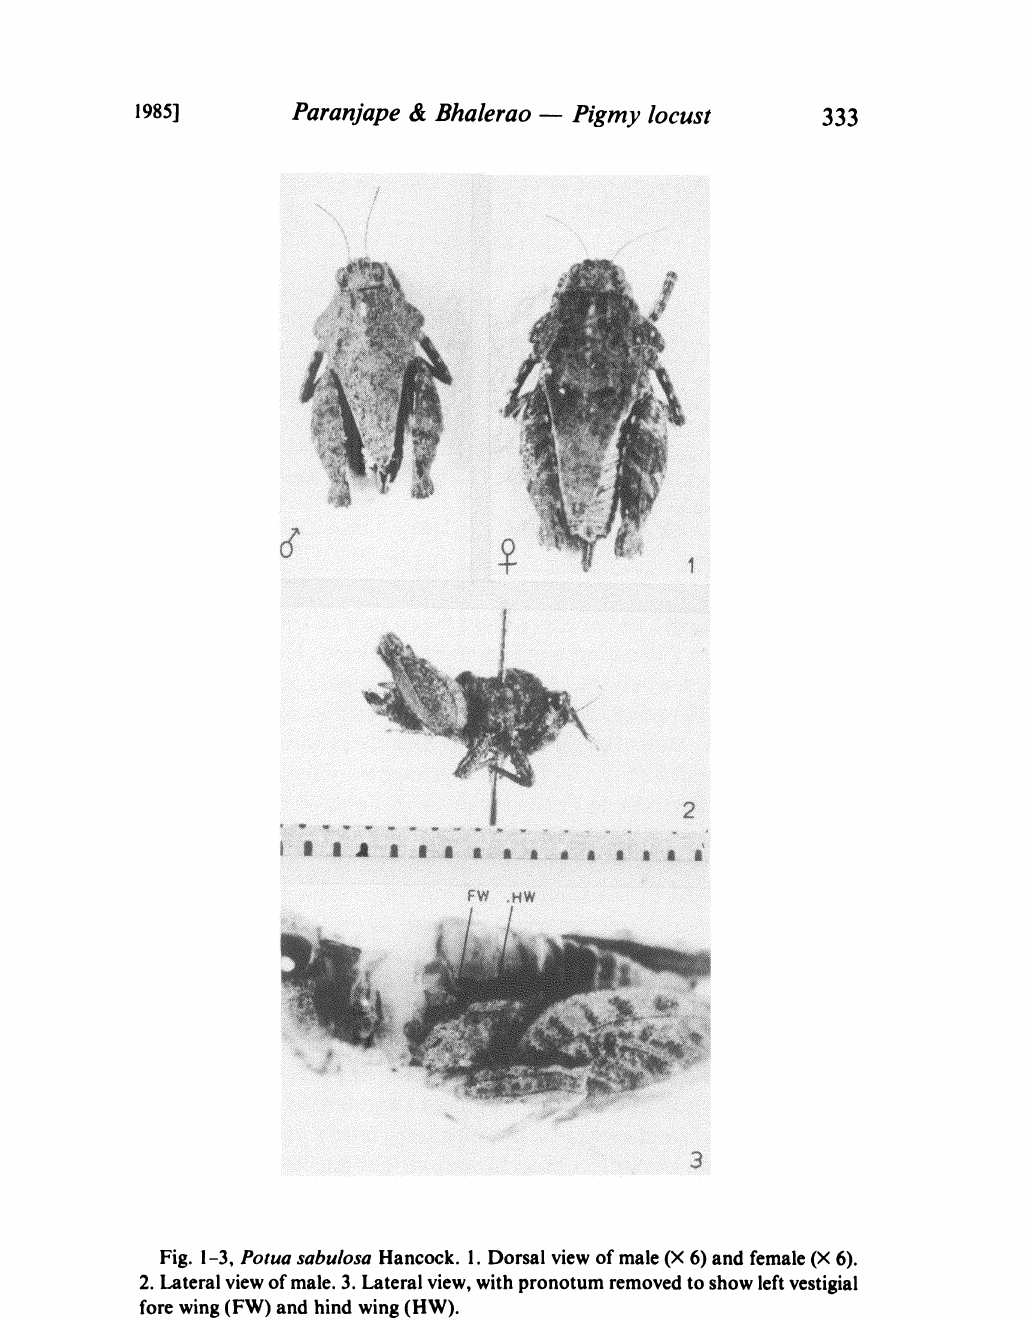
Fig. I-3, Potua sabulosa Hancock. 1. Dorsal view of male ( 6) and female ( 6). 2. Lateral view of male. 3. Lateral view, with pronotum removed to show left vestigial fore wing (FW) and hind wing